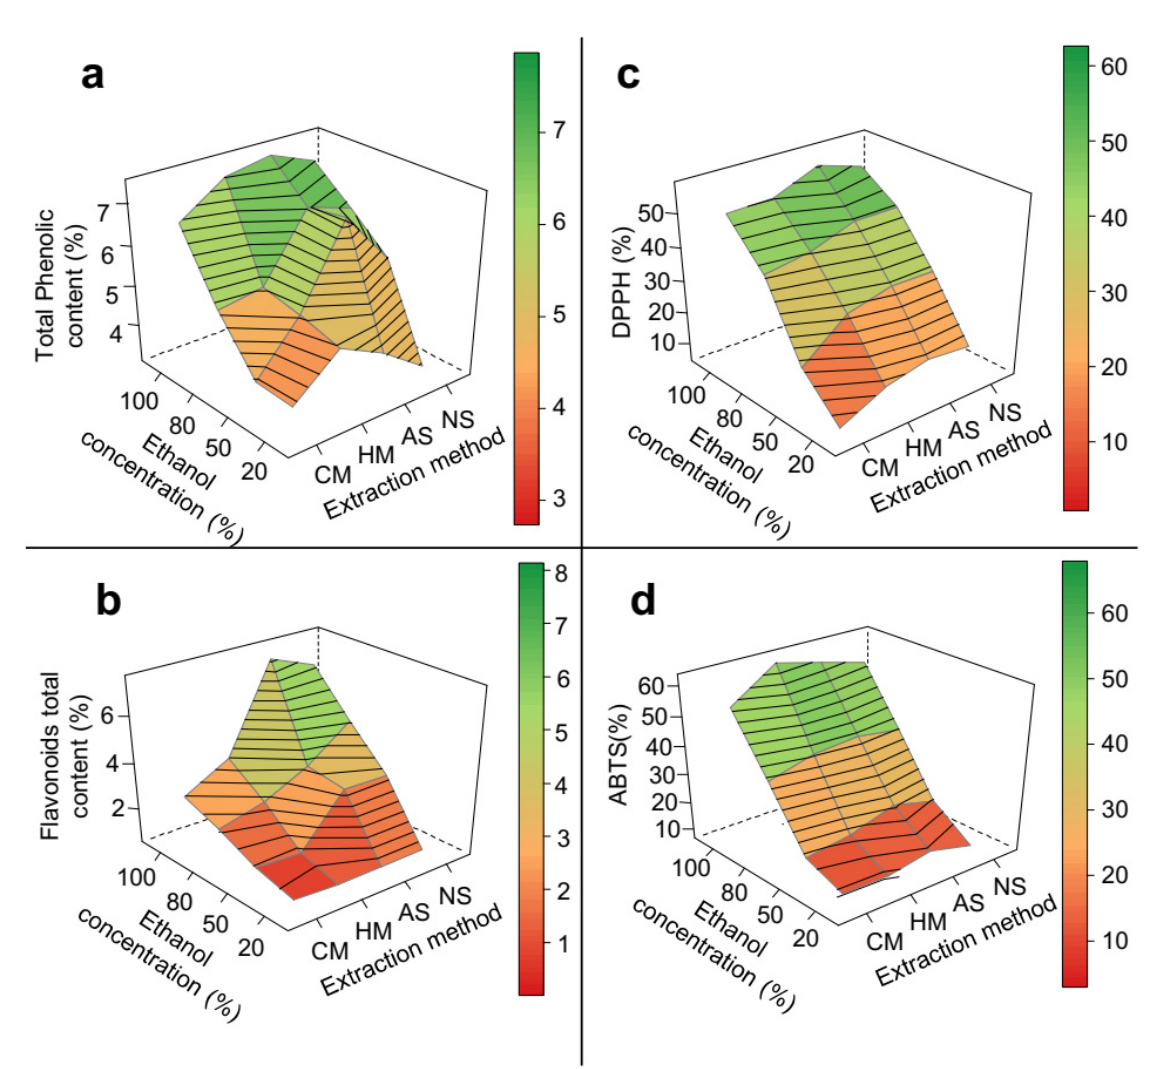
Figure 3. 3D response surface graph of the optimization of phenolic extraction from P. insignis epicarp. ( a ) Total phenolic, ( b ) Total flavonoid, ( c ) DPPH, and ( d ) ABTS. CM = cold maceration; HM = hot maceration; AS = acid sonication; NS = neutral sonication; DPPH = Antioxidant capacity by DDPH assay; ABTS = Antioxidant capacity by DDPH assay.